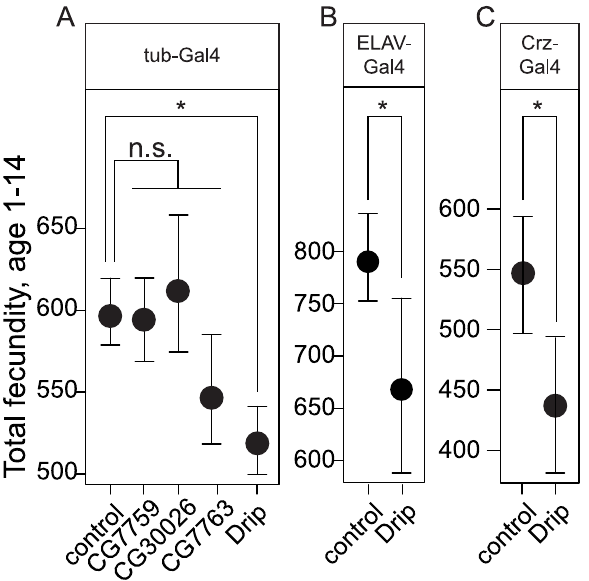
Figure 2. Effects of overexpression of RNAi constructs against positional candidate genes on female fecundity. (A) Ubiquitous overexpression by the tub-Gal4 of RNAi constructs against driver for four of the five candidate genes. (B) Overexpression of Drip-RNAi with the pan-neuronal driver, Elav -Gal4, reduces female fecundity. (C) Overexpression of Drip-RNAi in corazonin producing neurons reduces female fecundity. Error bars represent 95% CI based on non-parametric bootstrap resampling (5000 replicates), conditional on fly. Asterisks represent significant difference from the control at p , 0.05. doi:10.1371/journal.pgen.1002631.g002 and carcasses (thorax, legs, wings, and the abdomen except the ovaries-LRT) from 3–5 day old mated females. Drip mRNA abundance did not differ among alleles in samples from the ovary- LRT or the carcass (ovary + LRT p = 0.3, carcass p = 0.28; Figure 3A). On the other hand, Drip mRNA was reduced , 2.7